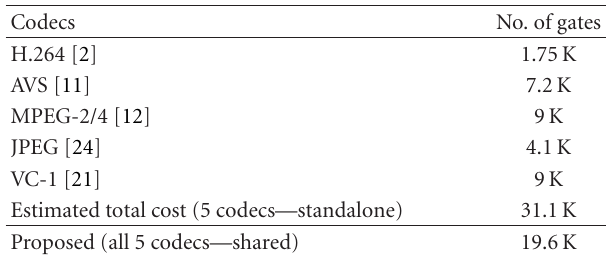
Table 5: Comparison of multiquantization schemes (VLSI imple-